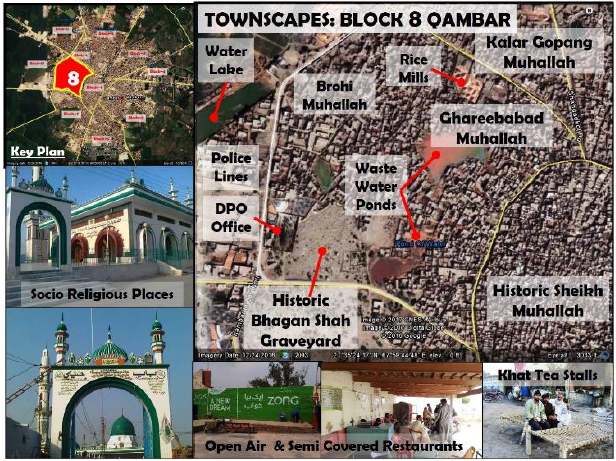
Fig. 12 . Townscape’s analysis of Qambar: serial vision and